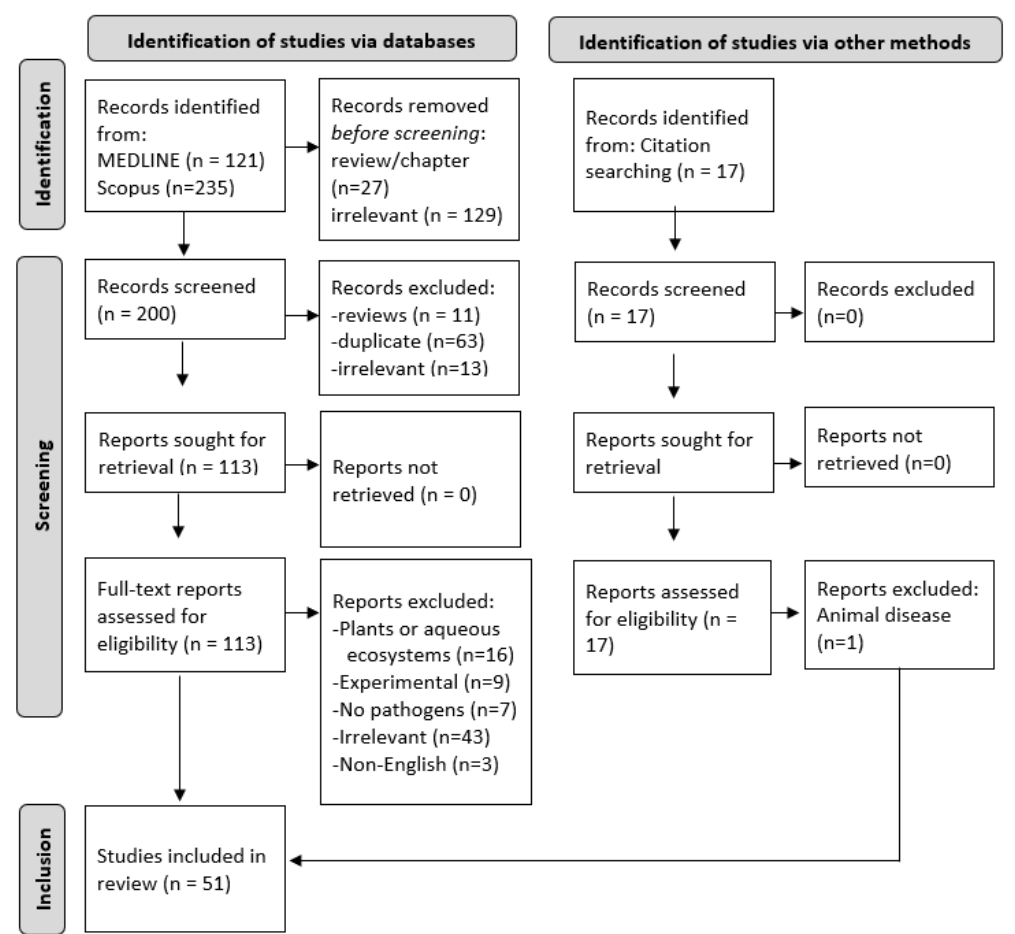
Figure 1. PRISMA flow diagram of study selection. PRISMA, Preferred Reporting Items for Sys- tematic Reviews and Meta-Analysis.